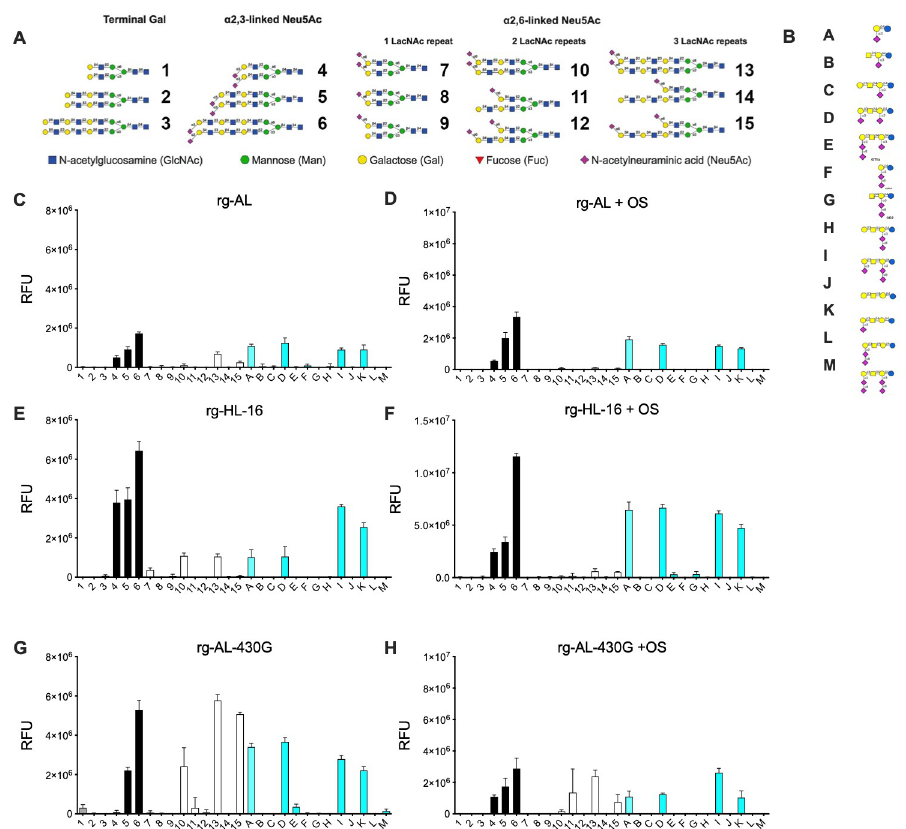
Fig 8. The impact of NA on binding specificity to avian- and human-like glycan moieties. Shown in numbers are N-glycan compounds terminating in gal (#1–3), avian type receptors (#4–6, black bars) and human type receptors (#7– 15, white bars) (A). Glycolipids presentation of avian-type receptors are shown as #A-M magenta bars [25,80] (B). Viruses were applied to the array surface in the absence (C, E, G) or presence of oseltamivir (OS) (D, F, H) at concentration of 200 nM (n = 4). Representative results for three independent experiments are shown for rg-AL (C and D), rg-HL-16 (E and F) and rg-AL-430G (G and H).